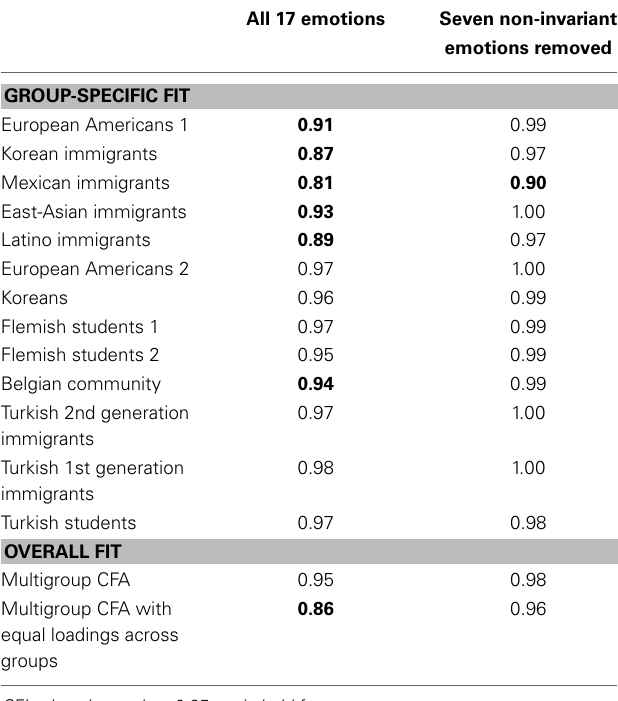
Table 2 | Comparative fit indices (CFI) for multigroup CFA analyses imposing positive affect and negative affect factors for the emotional acculturation data.